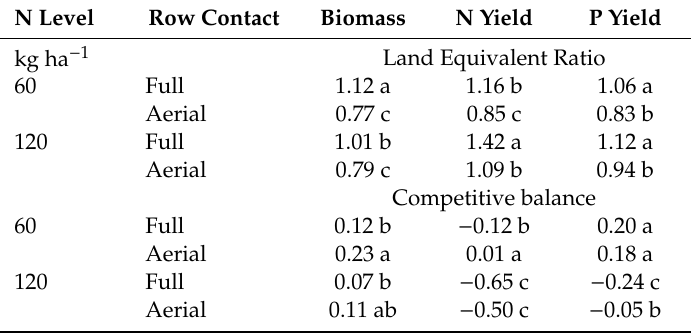
Table 1. Land Equivalent Ratio of intercrop versus sole crop and Competitive balance of field bean and triticale in the intercrop, as affected by the N level x Row contact interaction. For each parameter, values followed by the same letter within a column are not significantly different at P < 0.05, Tukey’s test.